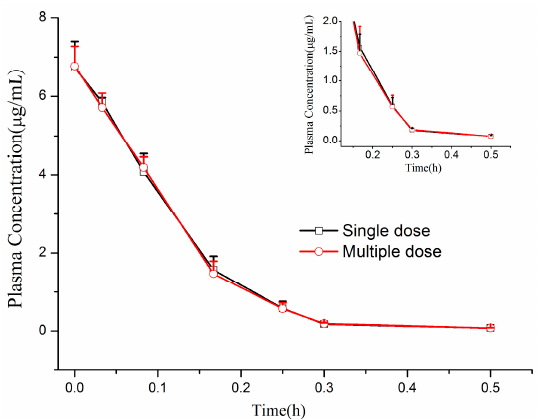
Figure 3. Mean plasma concentration–time profiles of CMME after single and multiple intravenous administrations (1.2 mg/kg/day, three times a day for seven days). Table 6. Mean pharmacokinetic parameters of CMME after i.v. of a single-dose of 1.2 mg/kg and multiple-dose of 1.2 mg/kg/day (three times a day) for seven days to beagle dogs (mean ± SD) ( n = 6).